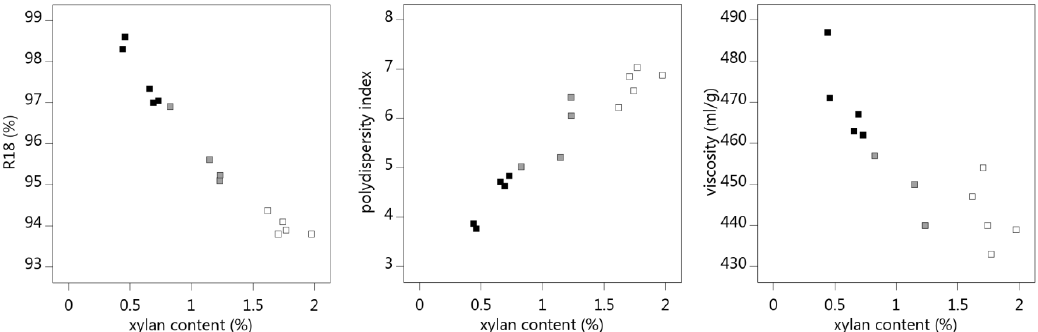
Figure 4. Observed correlations between pulp xylan content and R18 ( − 0.983), the polydispersity index (0.960), and pulp viscosity ( − 0.846). The dot colour corresponds to the NaOH concentration of the respective experiment: white, 40 g/L; grey, 80 g/L; black, 120 g/L.